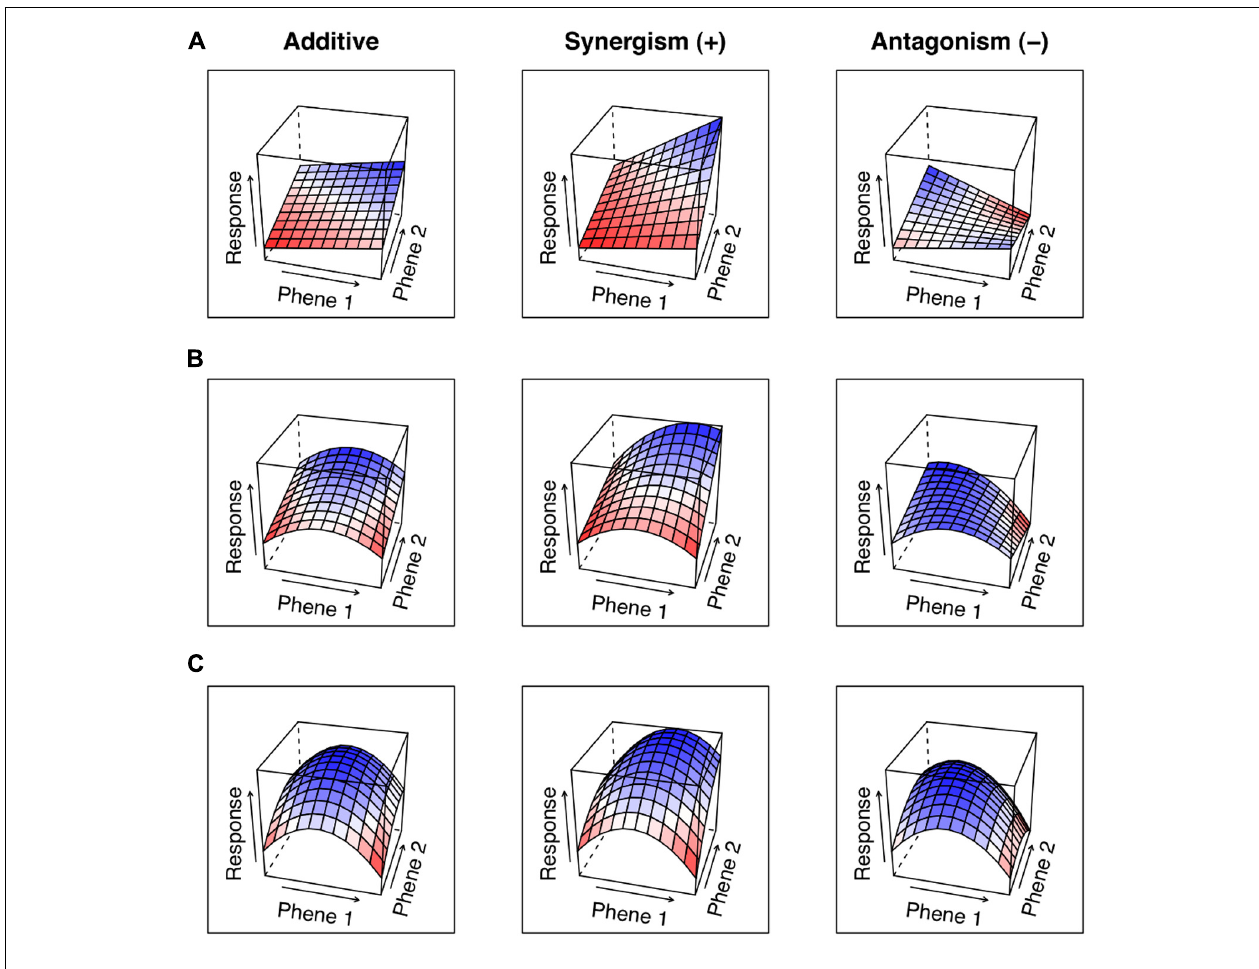
FIGURE 5 | Panel (A) shows the functional response landscape of two phenes that have linear effects in isolation. Panel (B) shows one phene with a linear effect and one with a central optimum. Panel (C) shows two phenes